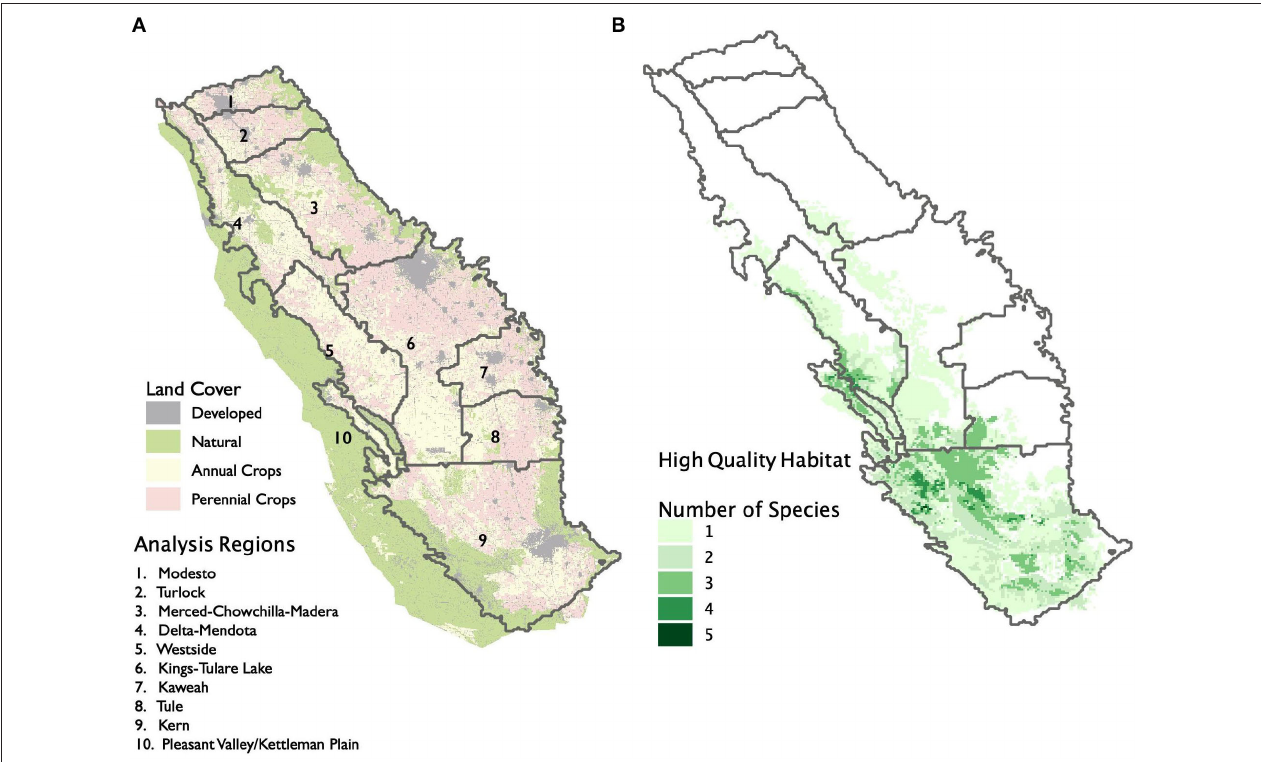
FIGURE 1 | San Joaquin Valley Study Area. (A) The present day land uses, distinguishing remaining natural areas from annual and perennial crops, and including the Diablo and Temblor ranges to the west outside the valley floor. The 10 regions shown are analysis units for our study, which correspond to subbasins designated for coordinated groundwater management by the California Department of Water Resources (some regions group multiple subbasins into one unit for analysis purposes). (B) Aggregate potential habitat quality across the study area for five focal species (selected based on habitat needs deemed representative of the over 35 listed plant and animal species for the upland ecosystems in the San Joaquin Valley). Comparison of the natural area at right shows that most high quality areas serving several species have been converted to